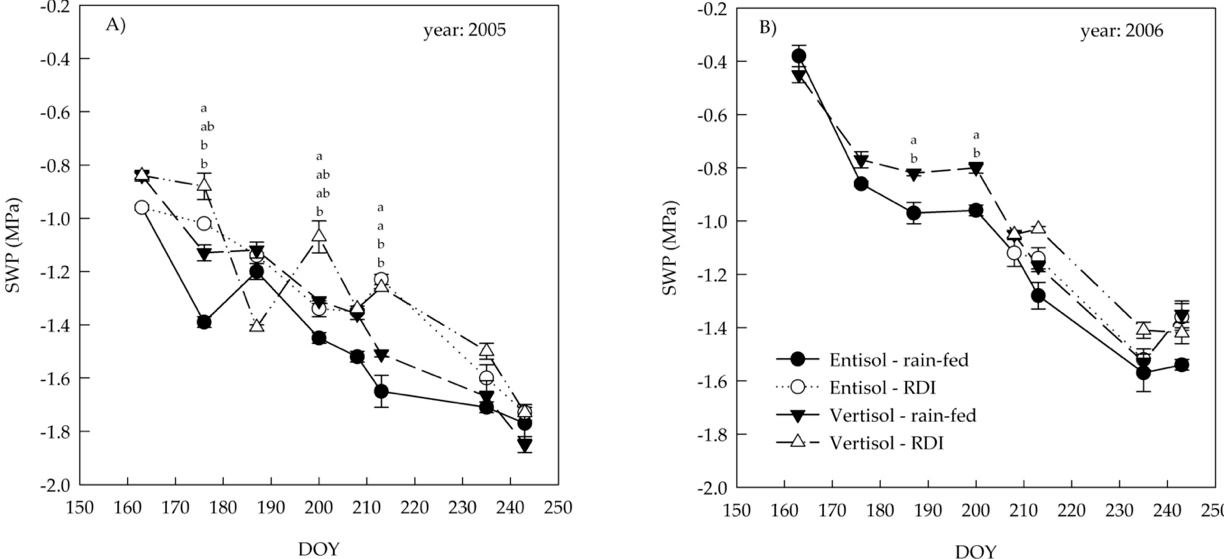
Figure 3. Variation in stem water potential (SWP) of ‘Nero d’Avola’ grapevines grown in two soils (entisol and vertisol)